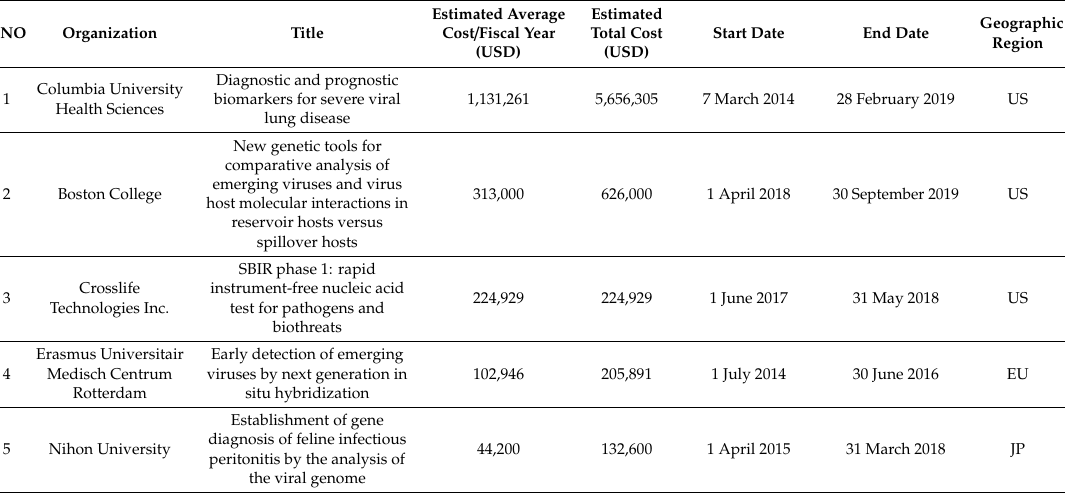
Table 4. The platform for detection and point-of-care diagnostics (Sub-Cluster 1-3).